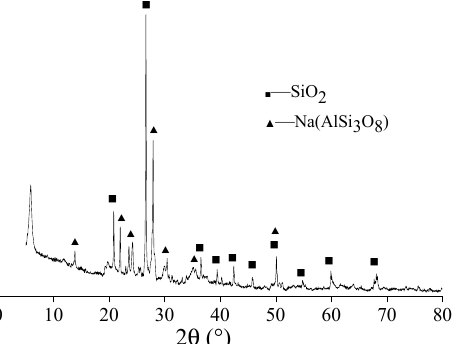
Figure 1. XRD test results of the natural weathered sand.